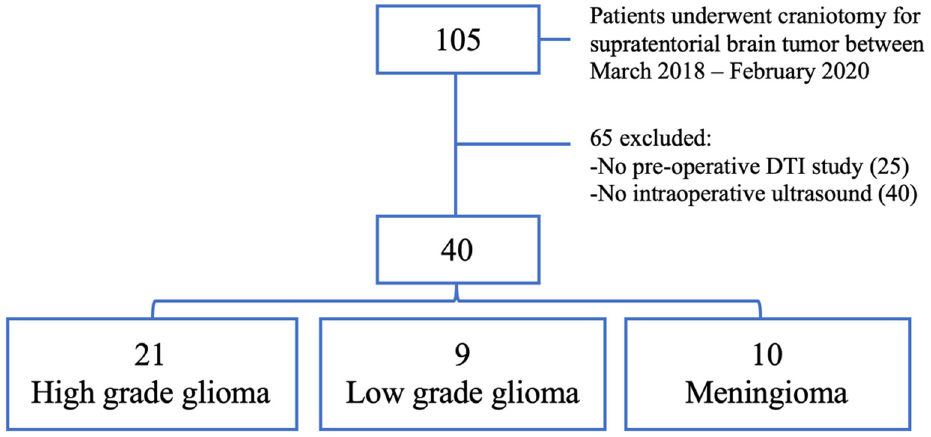
Figure 1. Flowchart showing the patient selection criteria.